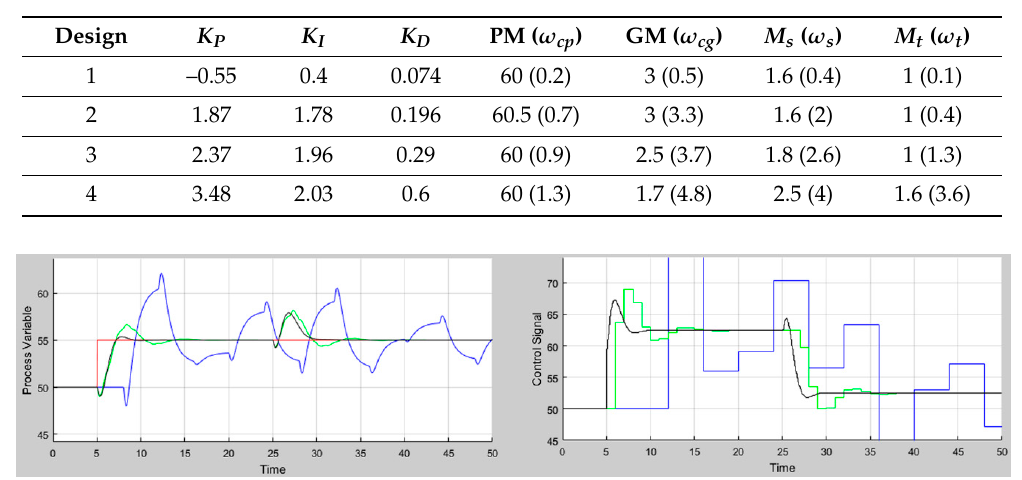
Figure 10. Schematic of the plant and experimental setup.